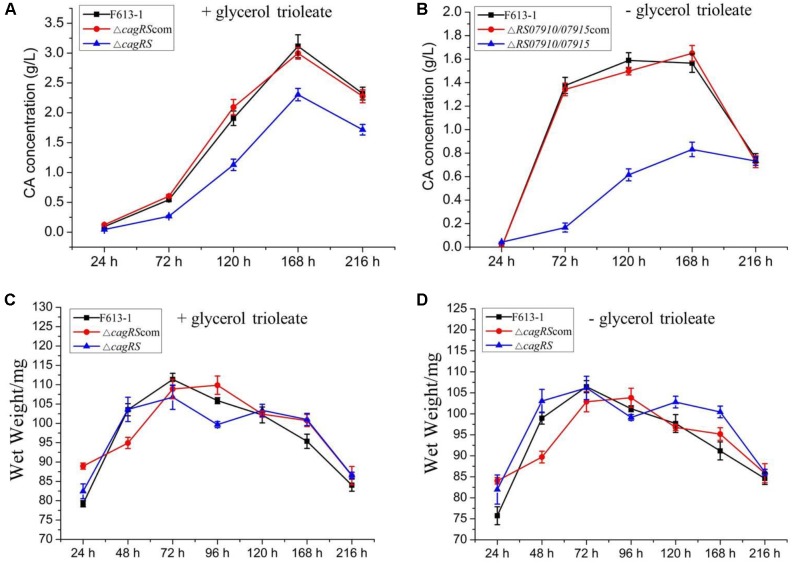
Clavulanic acid (CA) liquid fermentation titers of F613-1, ΔcagRS and the complemented strain. Analysis of the change of CA concentration during fermentation (A,B). For detecting CA production during the liquid fermentation process, spores (106/mL) were inoculated into 100 mL SCZ seed medium and cultured at 25°C, 200 rpm for 48 h to obtain seed cultures. Next, 5 mL seed cultures were transferred to 100 mL SCF fermentation medium supplemented with (A) or without (B) 1.6% (v/v) glycerol trioleate, and then grown at 25°C, 200 rpm for 216 h. To analyze CA concentration, 1 mL samples of fermentation liquid were collected at 24, 72, 120, 168, and 216 h, and centrifuged at 12000 rpm, 4°C, 5 min to collect the supernatant. Next, HPLC was performed immediately after the supernatant was filtered with a 0.22 mm filter membrane. (C,D) Growth curves of F613-1, ΔcagRS and ΔcagRScom with (C) or without (D) glycerol trioleate. Samples for growth curve analysis were harvested at seven time points (24, 48, 72, 96, 120, 168, and 216 h). Data are the mean ± SD of three separate experiments.